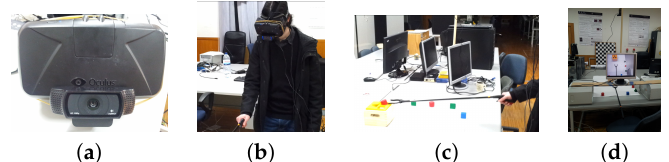
Figure 6. ( a ) “HMD indirect vision (mono biocular)”: a video see-through HMD; ( b , c ) user performing a pick and place task using the setup “HMD indirect vision (mono biocular) + gripper”; ( d ) user performing a pick and place task using the setup “fixed monitor vision (mono biocular) +